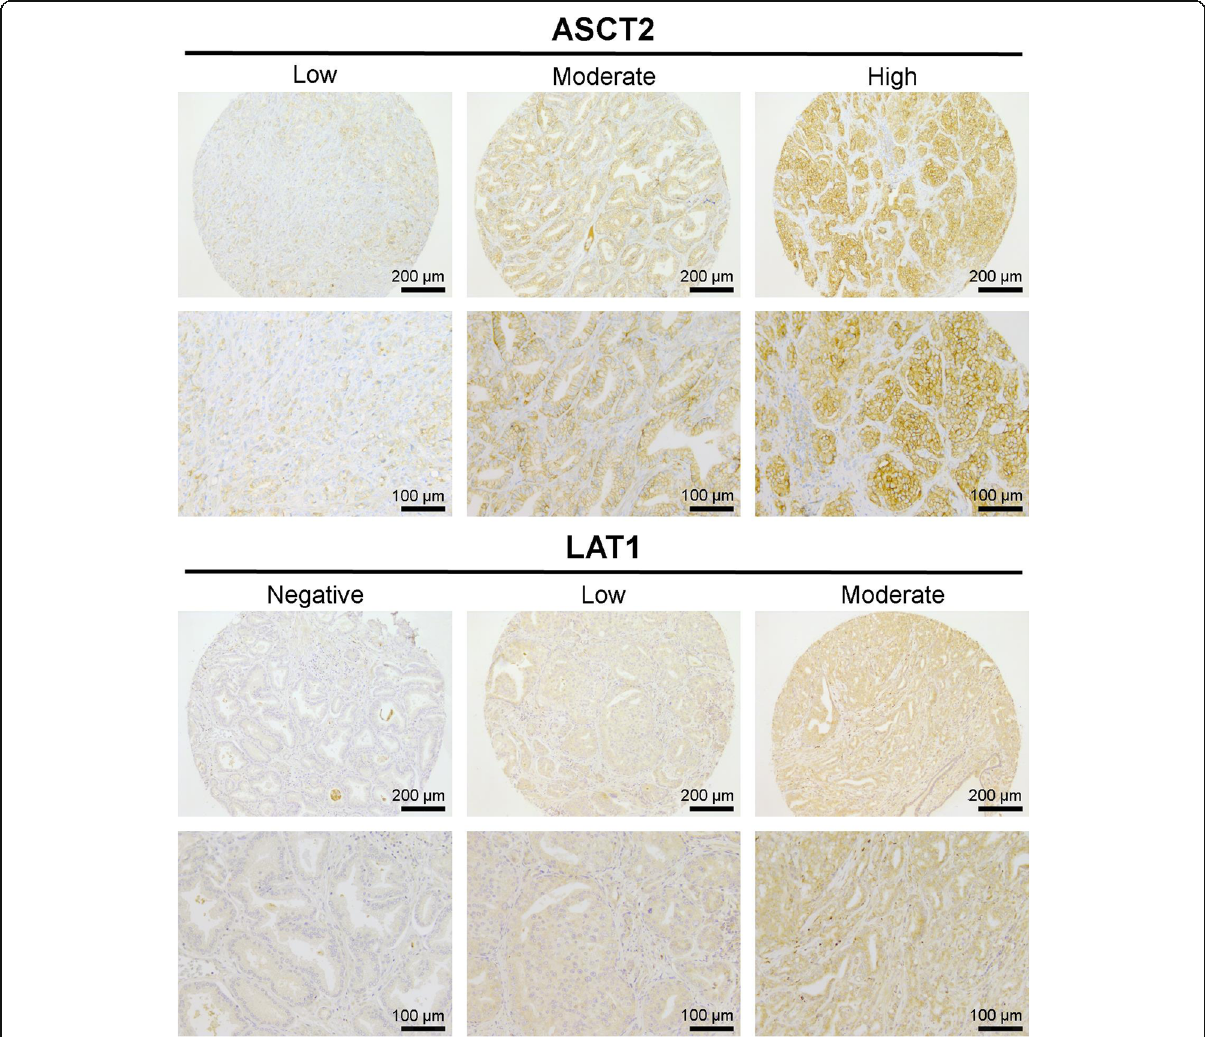
Fig. 1 Representative examples of different immunohistochemical (IHC) staining intensities of ASCT2 and LAT1 in tissue microarray (TMA). Low, moderate, and high IHC staining intensities (score 1 – 3) for ASCT2 and negative, low, and moderate IHC staining intensities (score 0 – 2) for LAT1 are shown at low (× 10, scale bar 200 μ m) and high (× 20, scale bar 100 μ m) magnification